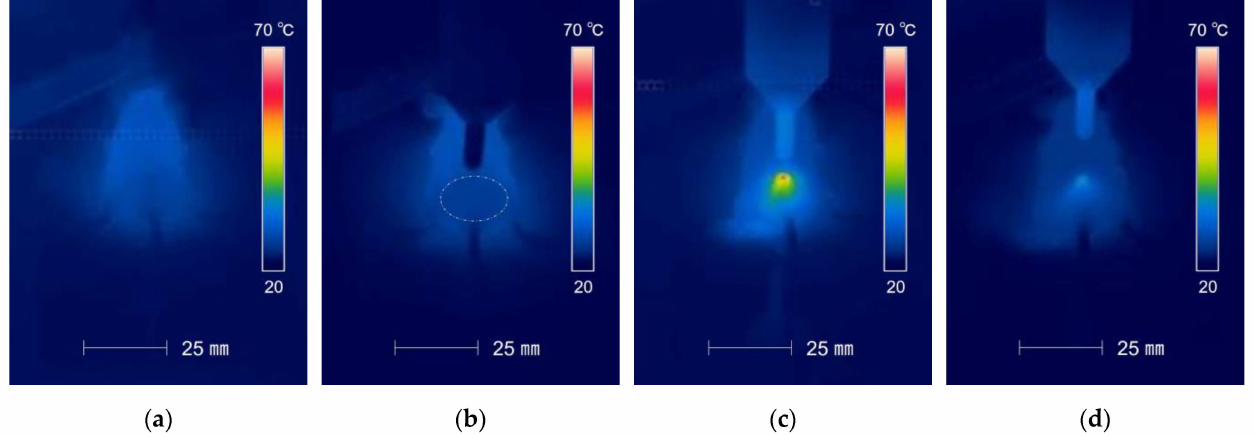
Figure 3. Thermal images taken on live mice ( a ) before treatment, ( b ) during He gas flow treatment at 15 min, ( c ) during contact plasma treatment at 15 min, and ( d ) during non-contact plasma treatment at 15 min.